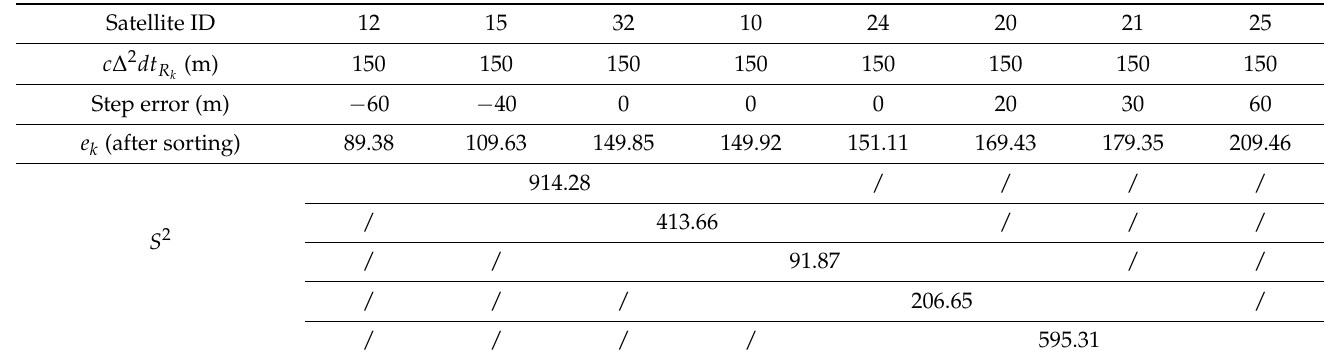
Table 7. An example of windowing results in Scenario